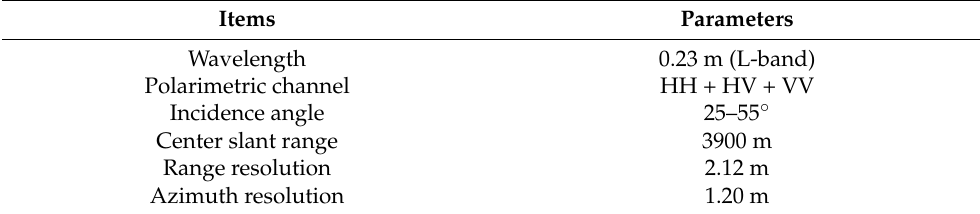
Table 2. The parameters of the E-SAR airborne system [40].